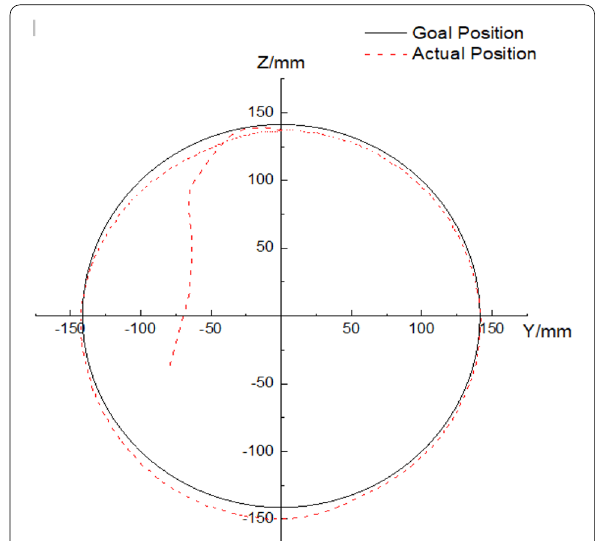
Figure 10 Error distribution of the fixed point by PD control